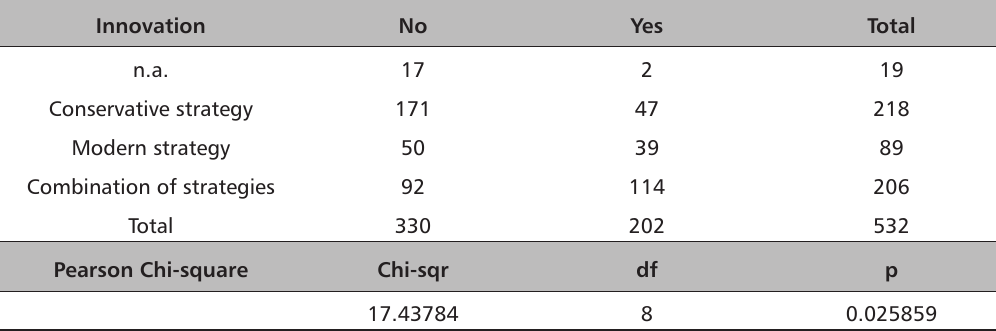
strategyn.a. stands for forest managers that did not choose any of the management strategy TABLE 7. Impact of management strategy on innovation activity*